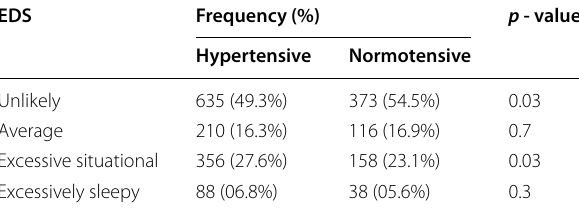
Table 2 Prevalence and pattern of Excessive Daytime